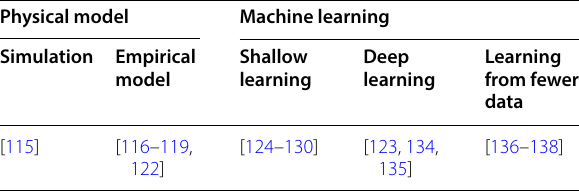
Table 6 Evolution of tool condition